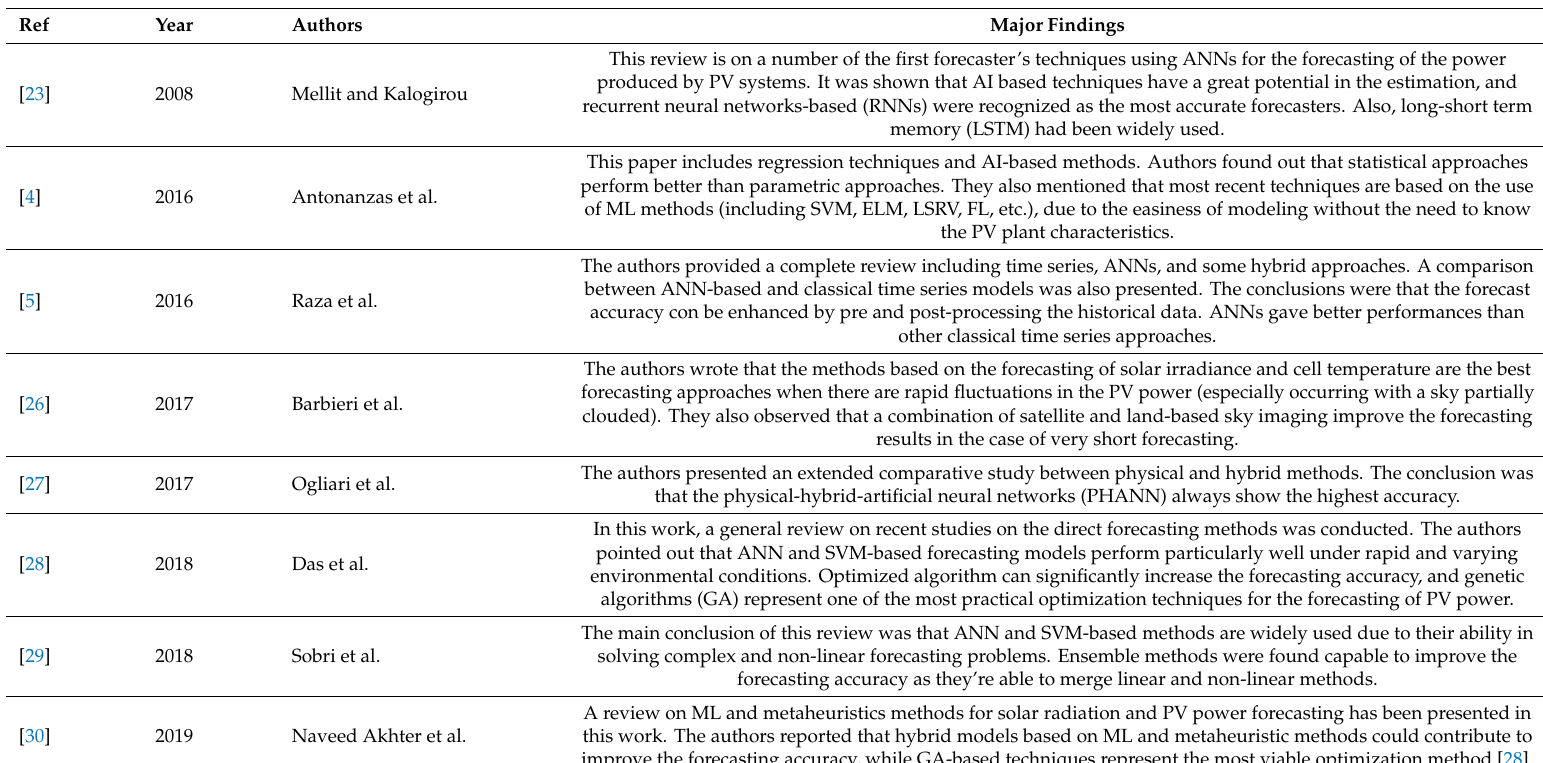
Table 1. Review papers on photovoltaic (PV) power